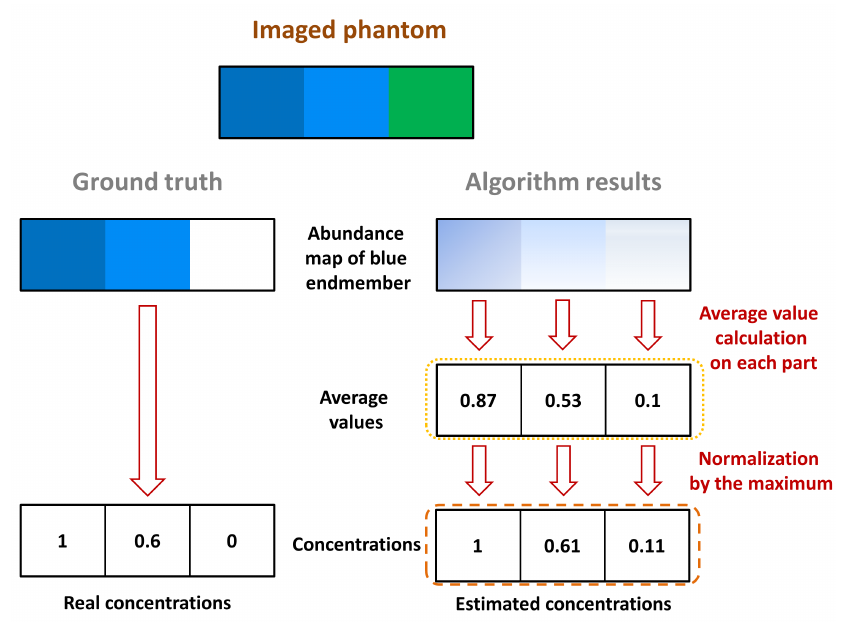
Figure 5. Performance validation procedure on an illustrative synthetic phantom. The validation here is for the estimation of the blue